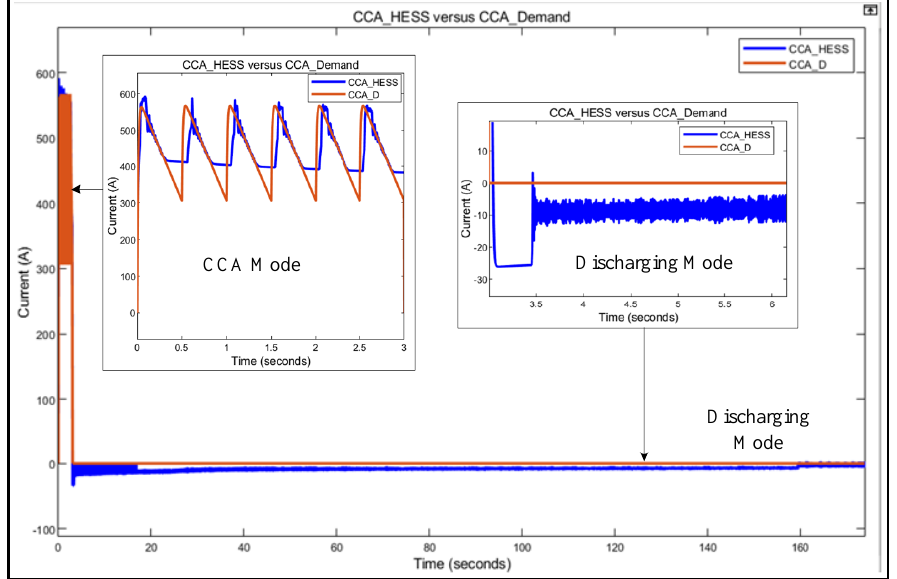
Figure 8. The CCC is supplied by the HESS for case two (a).